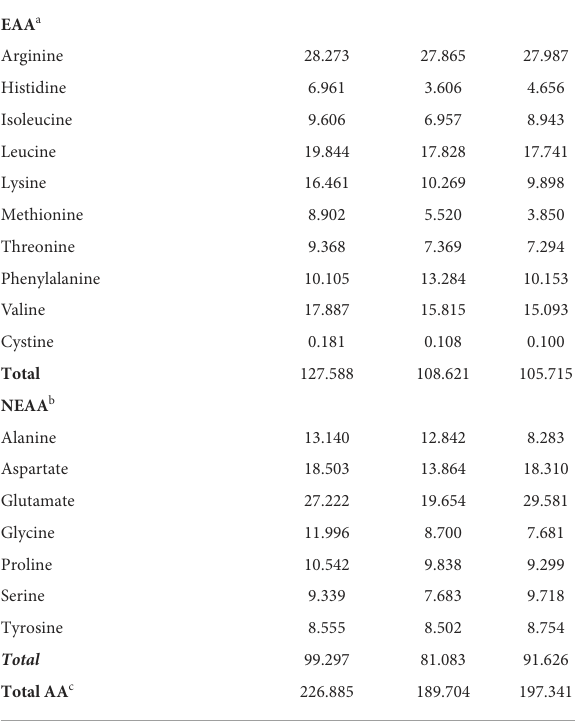
TABLE 3 Analysis of anti-nutritional factors (ANF) in microalgae and enzyme-treated soybean meal (ESBM). Microalgae